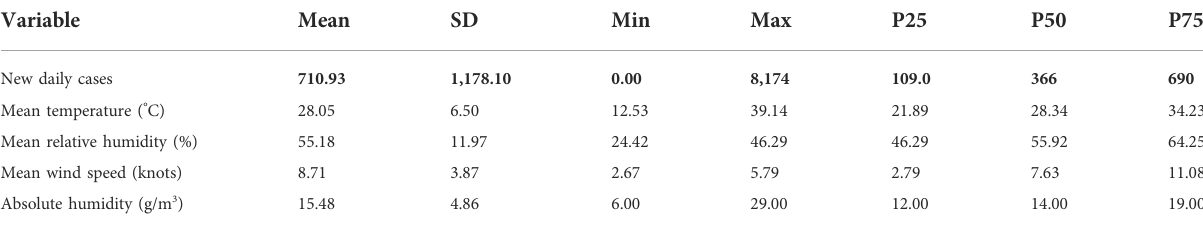
TABLE 3 Descriptive statistics for new daily cases and meteorological parameters ( n = 815).